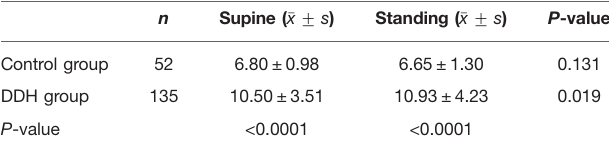
TABLE 3 | Correlation between TD changes and other hip